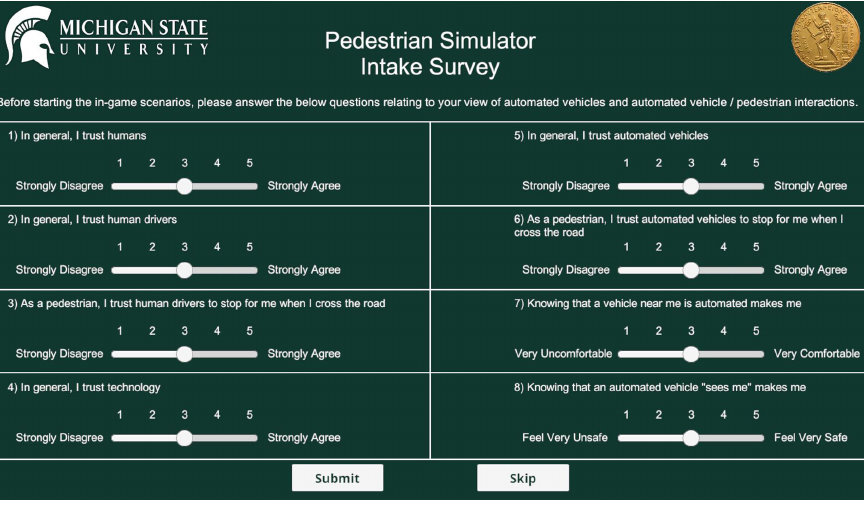
Figure 6. The Intake Survey is one of the four in-game surveys. Users need to complete it before testing any of the scenarios.